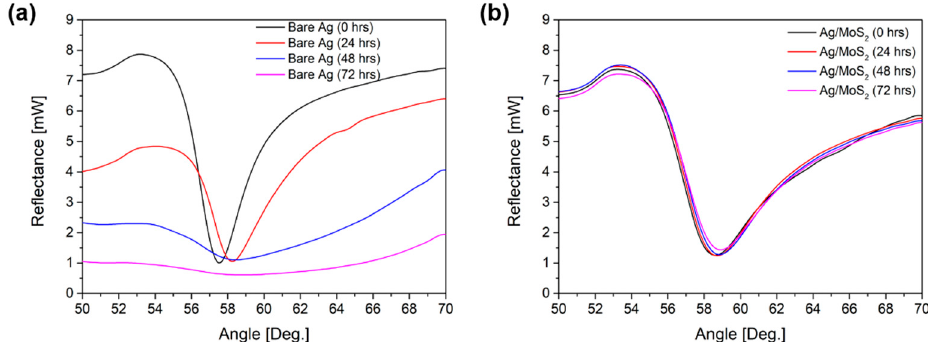
Figure 3. SPR signals of ( a ) bare Ag and ( b ) Ag / MoS 2 substrates in water. Silver oxidation may cause a broader SPR dip while Ag / MoS 2 substrate is stable due to impermeability to oxygen.